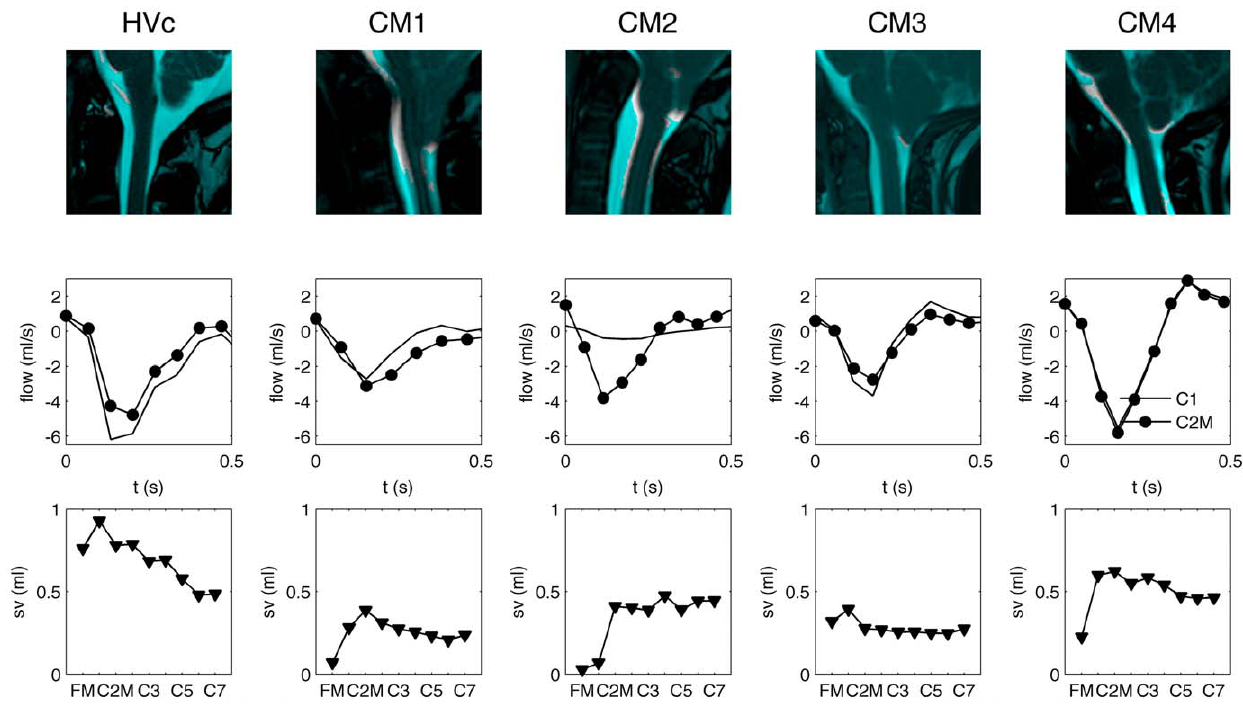
Figure 7. Motion analysis of the MRI images for healthy subject c (Hty c) and CM patients. Pixels in the image that are not masked in blue indicate tissue regions of the brain/spinal cord that move during the cardiac cycle. The larger the region, the greater the tissue motion; e.g. CM1, CM2 and CM4 appear to have the greater level of tissue motion in comparison to CM3. Unsteady CSF flow measured at the C1 and C2M is shown in the center row for each patient. CSF stroke volume (SV) at each axial location along the SSS (FM – C7) is shown in the bottom row for each subject.